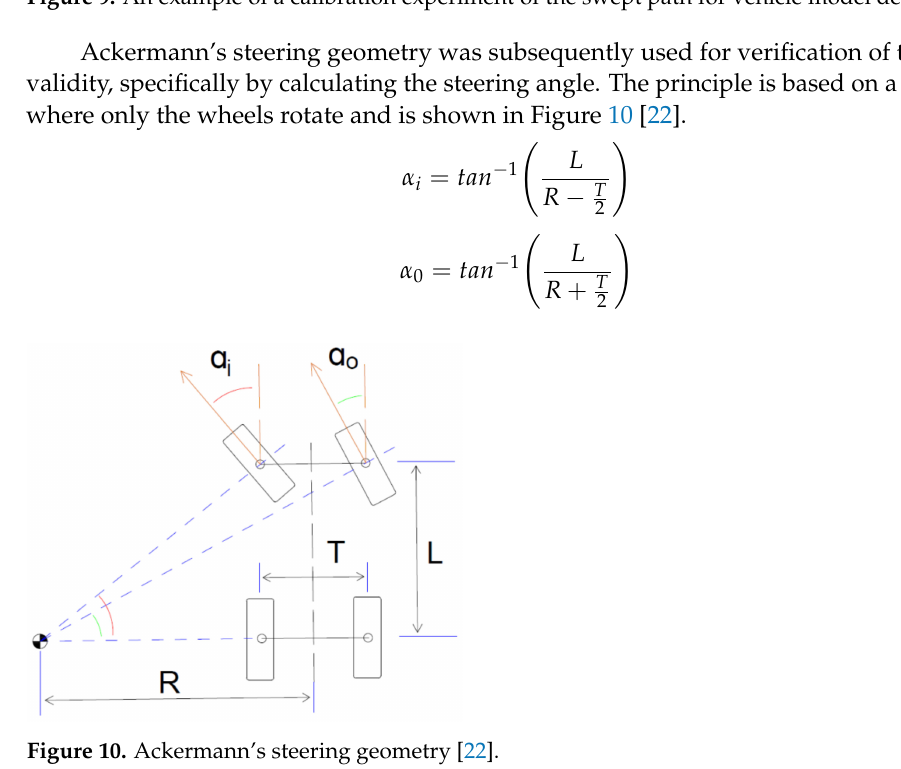
Figure 9. An example of a calibration experiment of the swept path for vehicle model design.